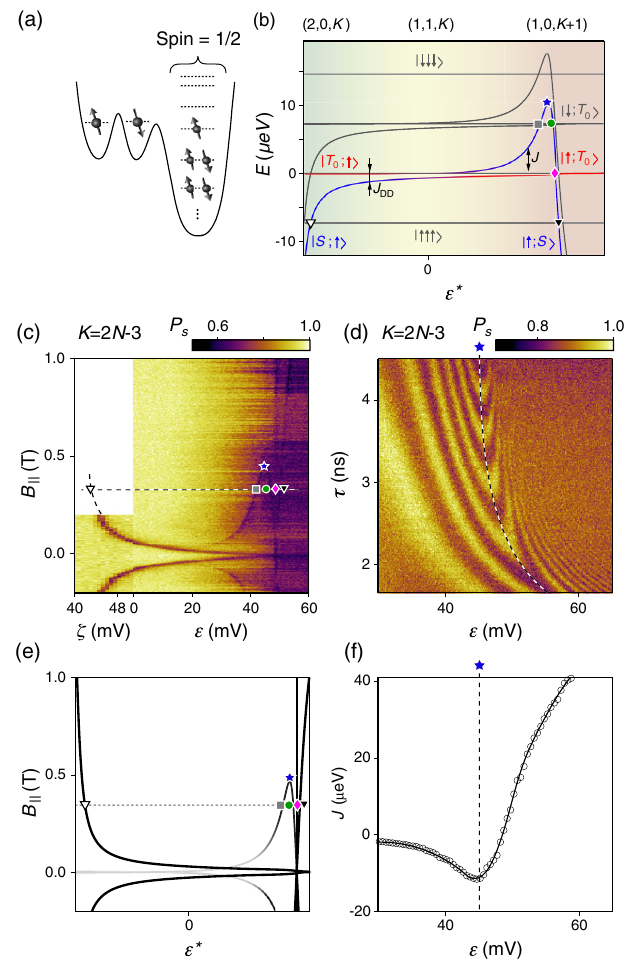
FIG. 7. (a) Schematic of the odd-occupied multielectron quan- tum dot with spin- 1 = 2 ground state, tunnel coupled to the two- electron double quantum dot. (b) The inferred energy diagram at the transition between ð 2 ; 0 ; 2 N − 3 Þ , ð 1 ; 1 ; 2 N − 3 Þ , and ð 1 ; 0 ; 2 N − 2 Þ charge configurations, for a finite magnetic field B k ¼ 330 mT. The markers indicate crossings revealed by the leakage spectroscopy measurement presented in (c). Energies are measured relative to the energy of the state j Q i ∝ j ↑↑ ↓ iþ j ↑ ↓ ↑ i þ j ↓ ↑↑ i . (d) Time-resolved measurement of exchange oscillations between the 2 N − 3 occupied spin- 1 = 2 multielectron dot and the middle electron, obtained at zero magnetic field. The dashed line indicates pulse parameters for which the resulting quantum state is to first order insensitive to fluctuations in ε . (e) Leakage spectrum expected from the Hubbard model. (f) Exchange profile J ð ε Þ extracted from the pattern of exchange oscillations in between states j S ; ↑ i and j ↑↑ ; ↑ i ( ¼ j ↑↑↑ i ). In this inter-